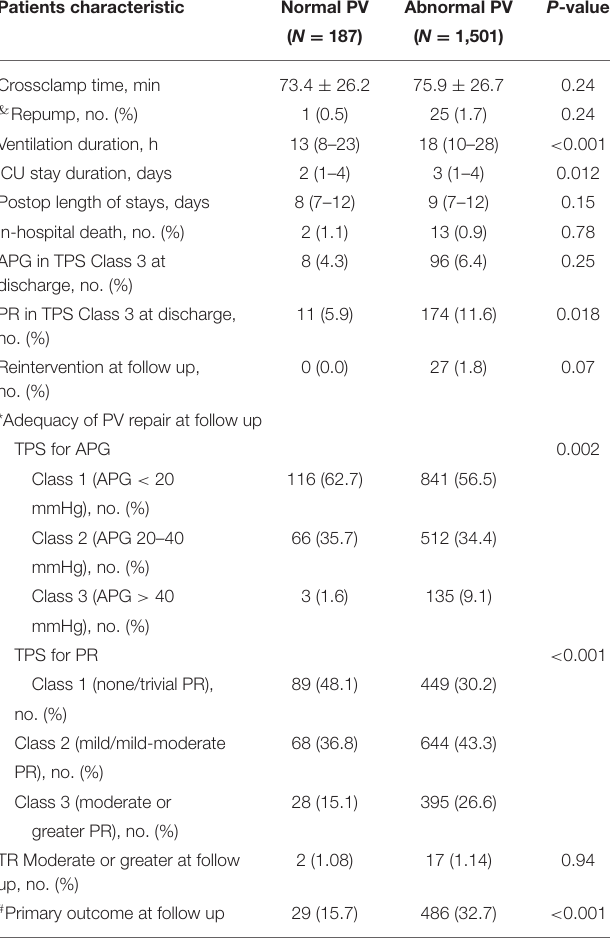
TABLE 2 | Clinical outcomes of patients with CR-TOF. Patients characteristic